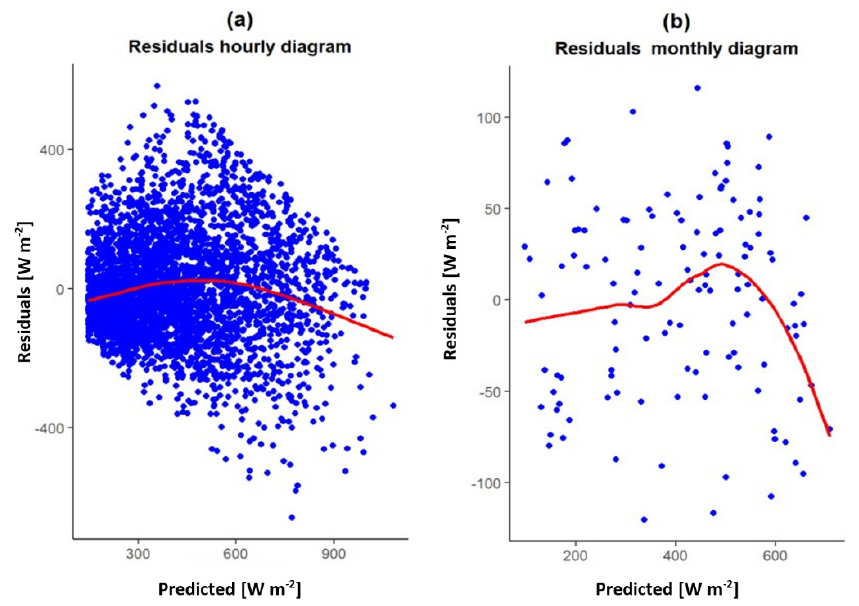
Figure 7. Scatterplots of normality test for hourly vs. monthly GHI profiles. Plot ( a ) represents the distribution of the predicted values versus residuals for the hourly profile. ( b ) shows the predicted values versus residuals for the monthly profile.